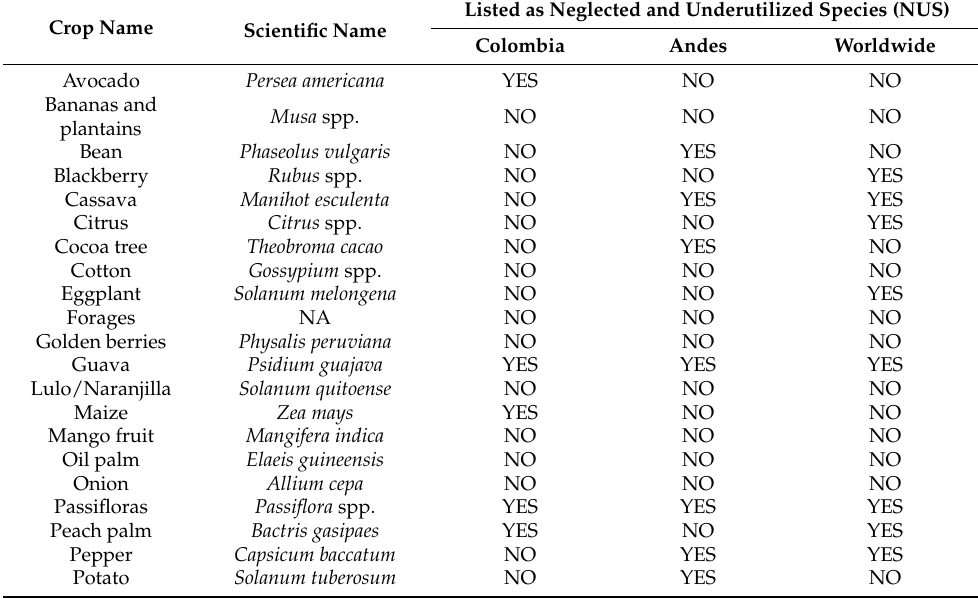
Table 2. List of crops that researchers in A GROSAVIA work on or have worked with in the last ten years (see Figure 2), and whether or not they are listed as neglected and underutilized species (NUS) at three different levels: Colombia, Andes, and worldwide [4–6]. The crops are in alphabetic order showing the scientific name when applicable (NA—not applicable).